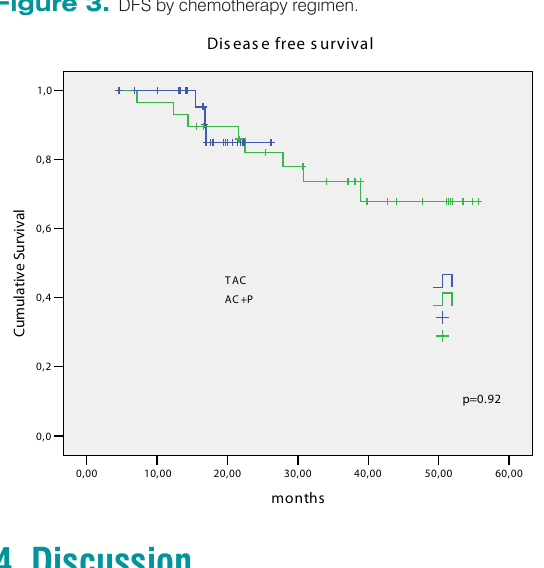
Figure 3. DFS by chemotherapy regimen.